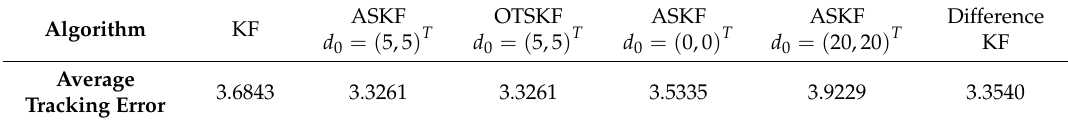
Figure 1. Comparison of the six algorithms when d k is a stationary time series. Table 2. The average tracking errors of the six